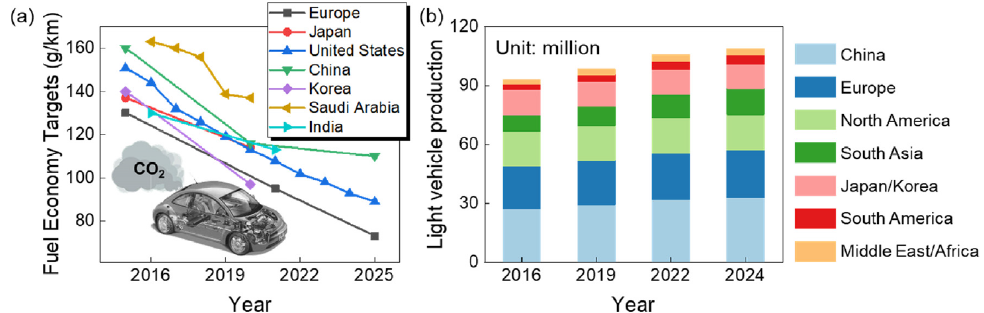
Figure 1. The current and future impact of lightweight materials in the automotive industry on ( a ) fuel economy and ( b ) production for the major markets. Reprinted from Ref. [9], open access.